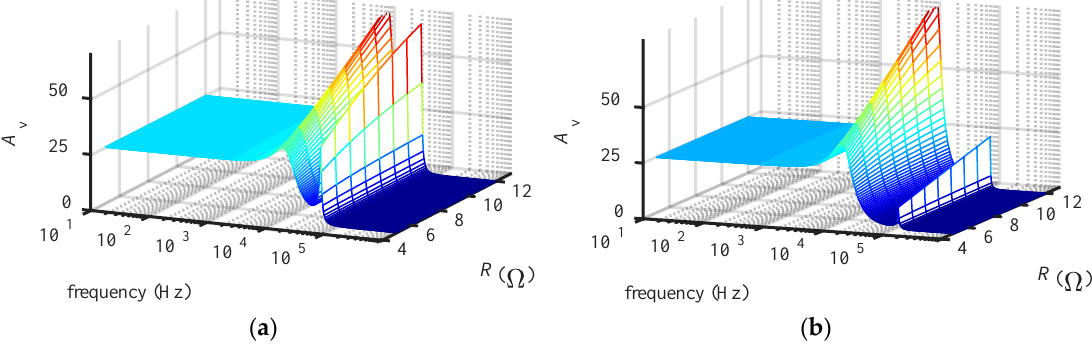
Figure 2. Open-loop frequency response of GaN class-D amplifier with fourth-order filter using ( a ) value set-i in Table 1 and ( b ) value set-ii in Table 1. Table 1. Parameters of GaN class-D amplifier with fourth-order